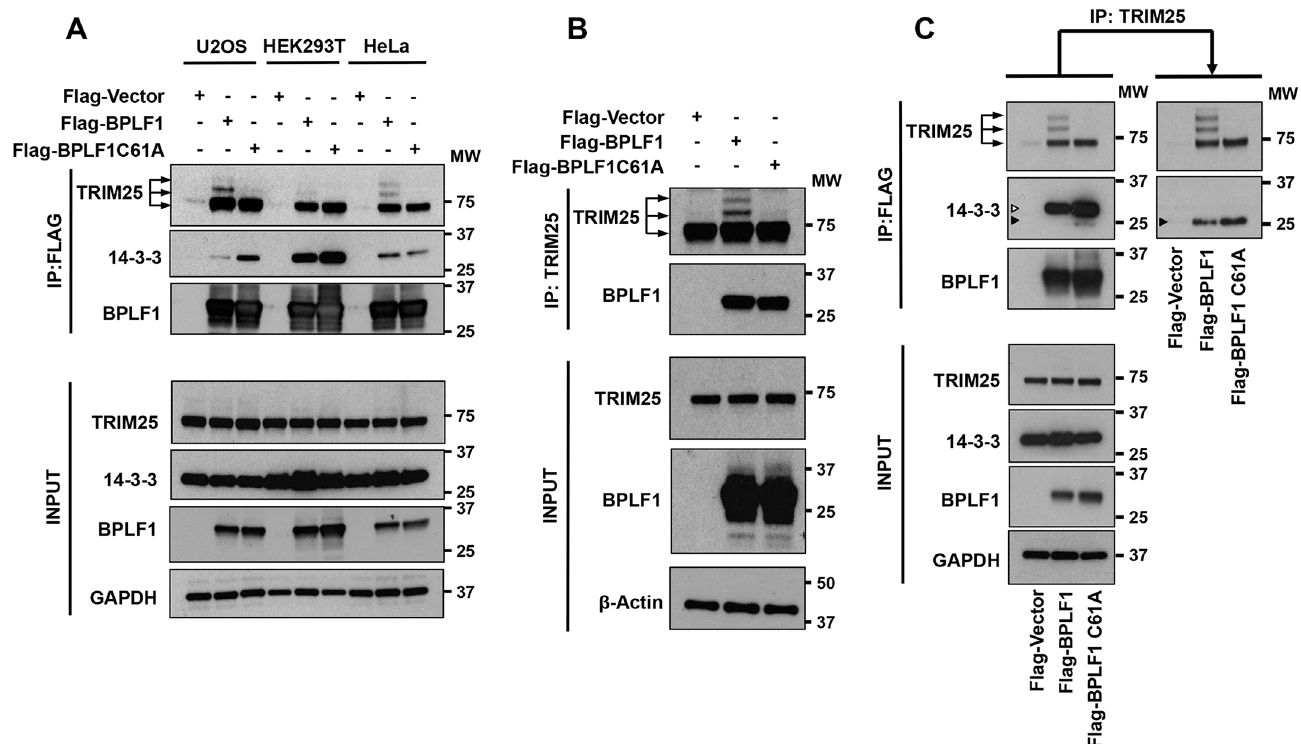
Fig 4. BPLF1 forms a tri-molecular complex with 14-3-3 and TRIM25. A . BPLF1 interacts with both 14-3-3 and TRIM25. HeLa, U2OS and HEK293T cells were transfected with the indicated plasmids and cell lysates were immunoprecipitated with anti-FLAG conjugated agarose beads (IP). Immunoblotting (IB) was performed with the indicated antibodies. B . TRIM25 interacts with BPLF1. HeLa cells were transfected with the indicated plasmids and cell lysates were immunoprecipitated with the anti-TRIM25 antibody (IP). Immunoblotting was performed with the indicated antibodies. C . BPLF1 forms a tri-molecular complex with 14-3-3 and TRIM25. Lysates of HeLa cells transfected with the indicated plasmids were immunoprecipitated with anti-FLAG conjugated beads and complexes eluted with the FLAG peptide were subjected to sequential immunoprecipitation with the anti-TRIM25 antibody. Immunoblots were probed with antibodies to 14- 3-3 and TRIM25. The two 14-3-3 specific bands are indicated by unfilled (upper band) and filled arrows (lower band). One representative experiment out of 3 is shown.